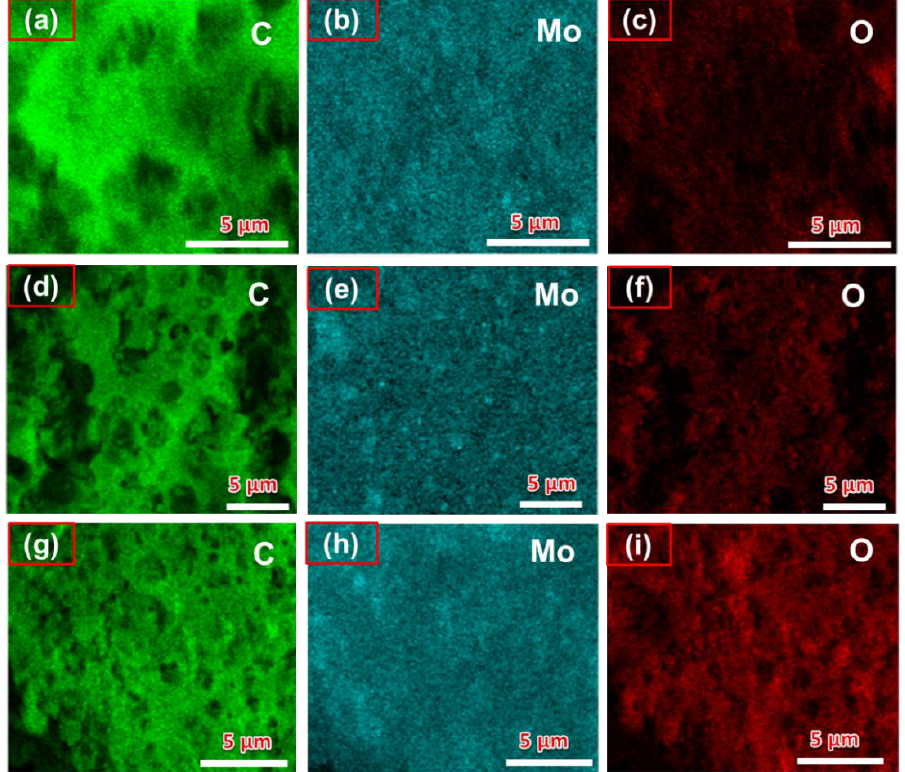
Figure 5. EDX mapping images showing the distribution of C, Mo and O individual elements in: ( a – c ) PAC/MoO 2 /Mo 2 C-0.5, ( d – f ) PAC/MoO 2 /Mo 2 C-1 and ( g – i ) PAC/MoO 2 /Mo 2 C-2 ternary compo- sites.